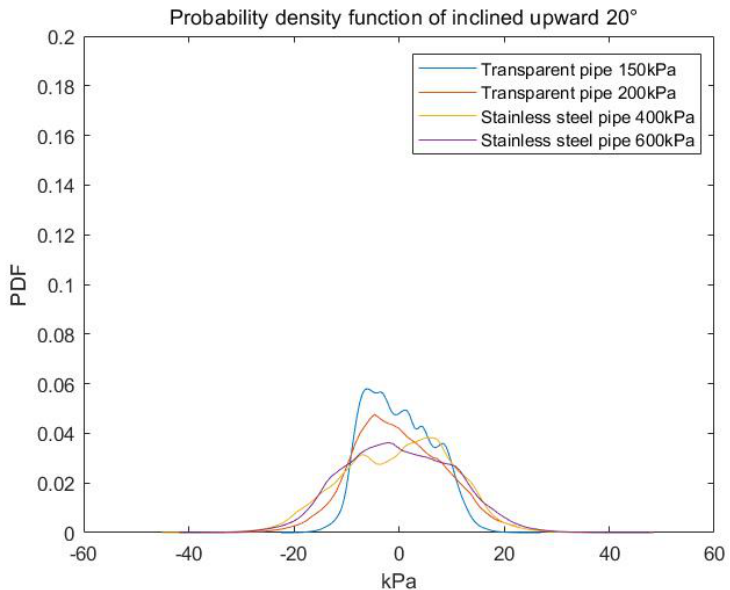
Figure 13. Probability density diagram of pipe pressure minus pipe pressure when inclined upward by 20°.